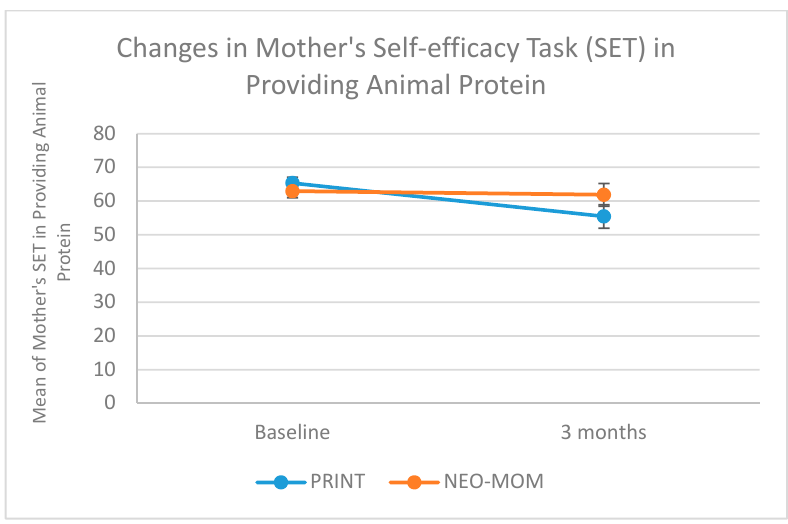
Figure 5 Profile plot of maternal self-efficacy (task) for providing animal protein. Figure 5. Profile plot of maternal self-efficacy (task) for providing animal